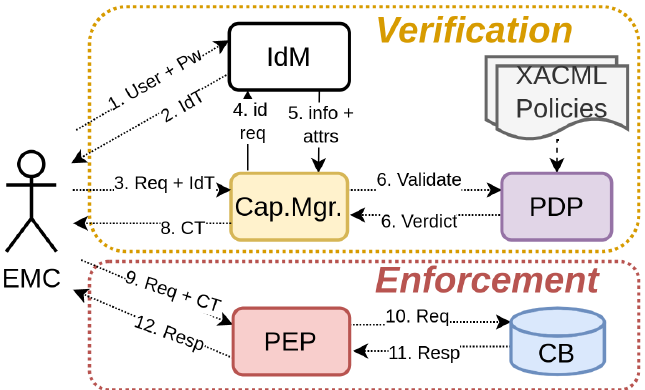
Figure 7. Context authorisation and access